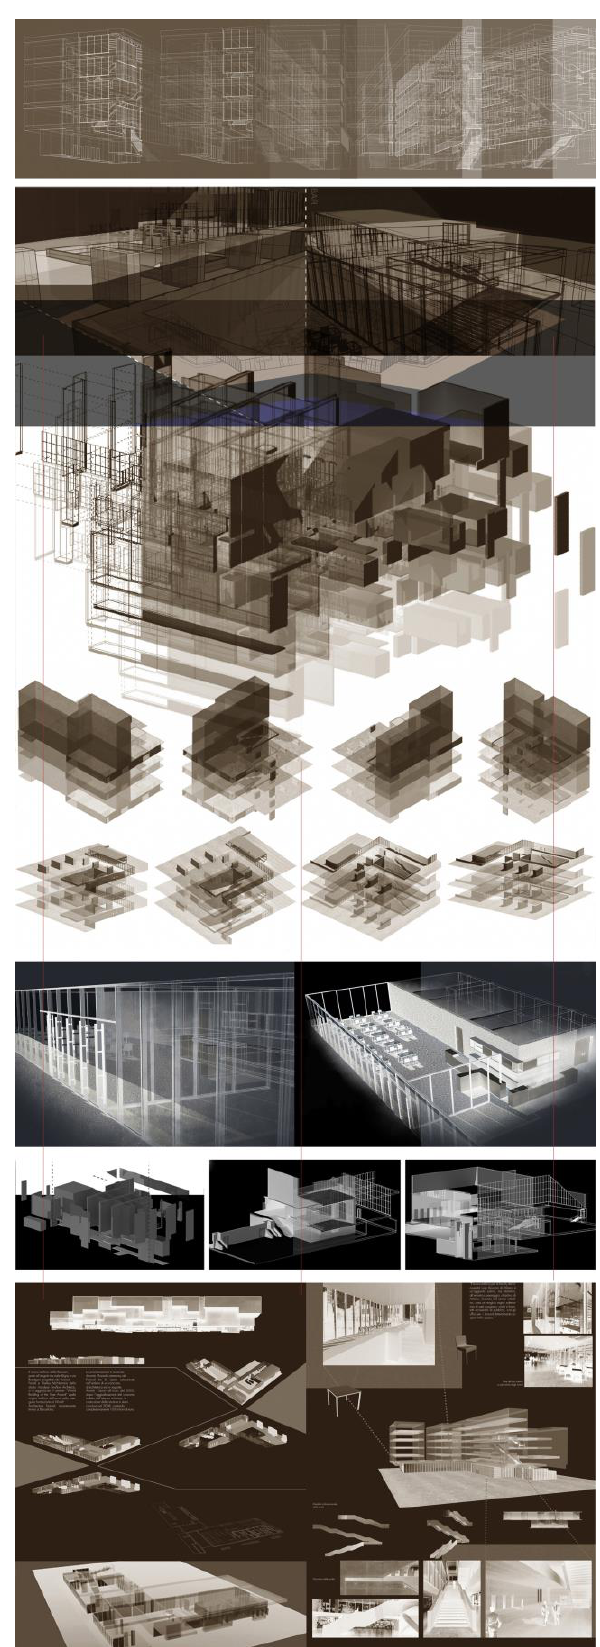
Figure 7. New Bocconi University, Milan - Grafton building (2008). IMM: Digital and Visual Apparatus. Brera Academy of Fine Arts Milan and II School of Architecture, Polytechnic of Milan (A. De Masi).